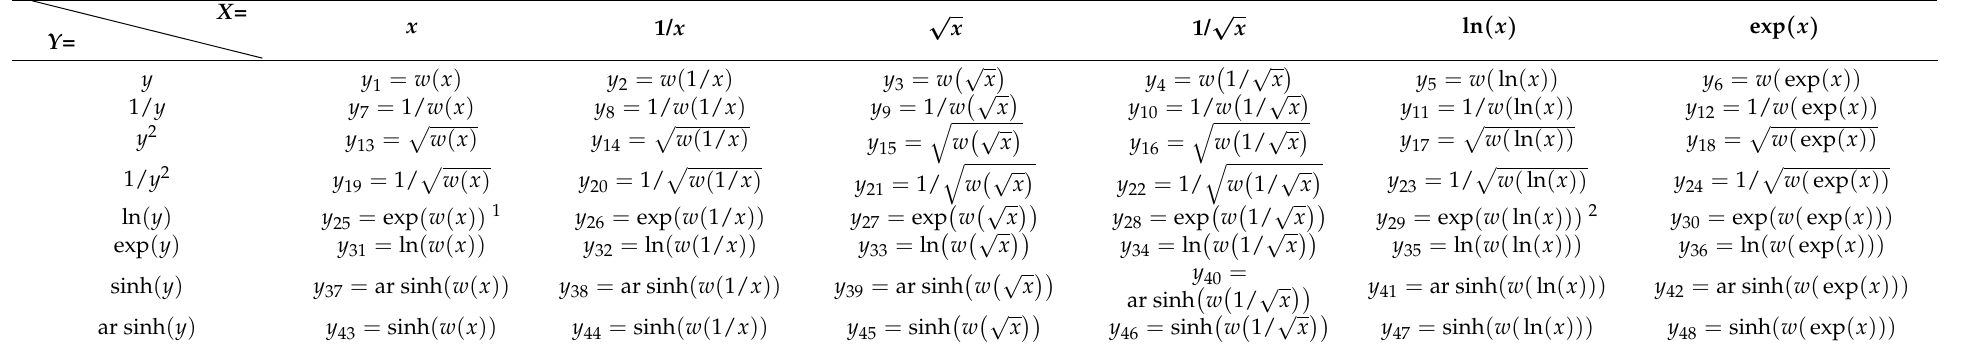
Table 1. Considered groups of